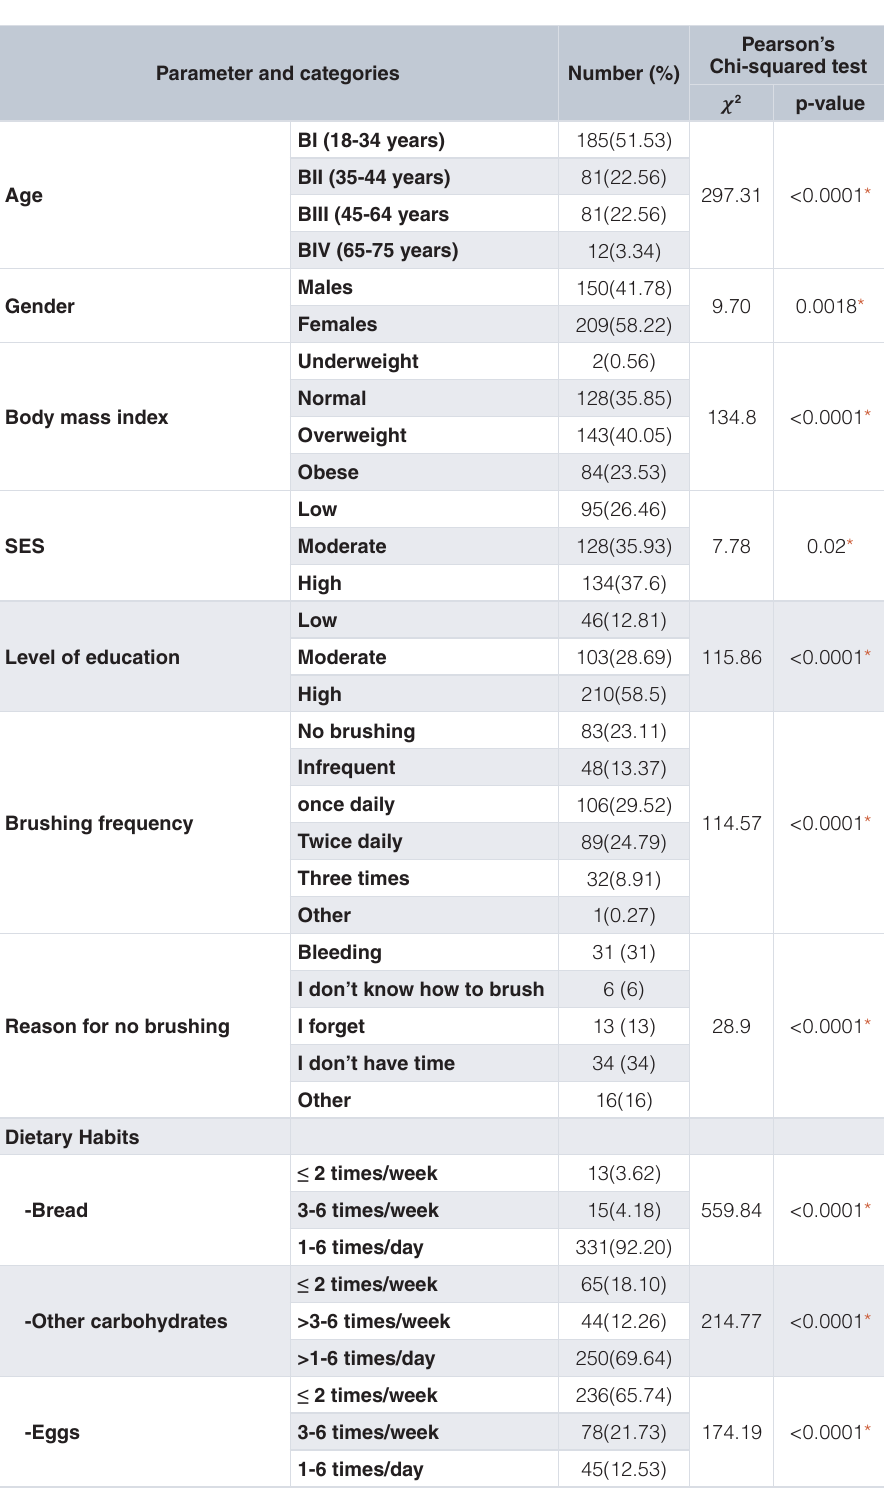
Table 1. Descriptive analysis of categorical variables and comparisons between proportions